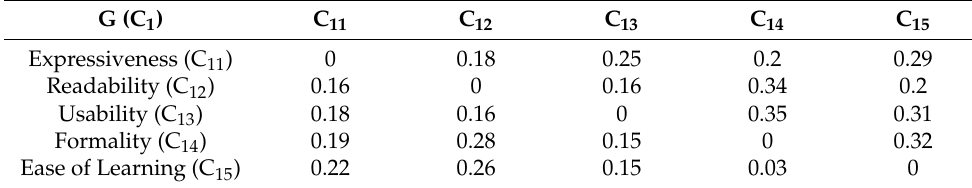
Table 11. Normalized direct influence matrix T between Efficiency (C 1 ) sub-criteria.